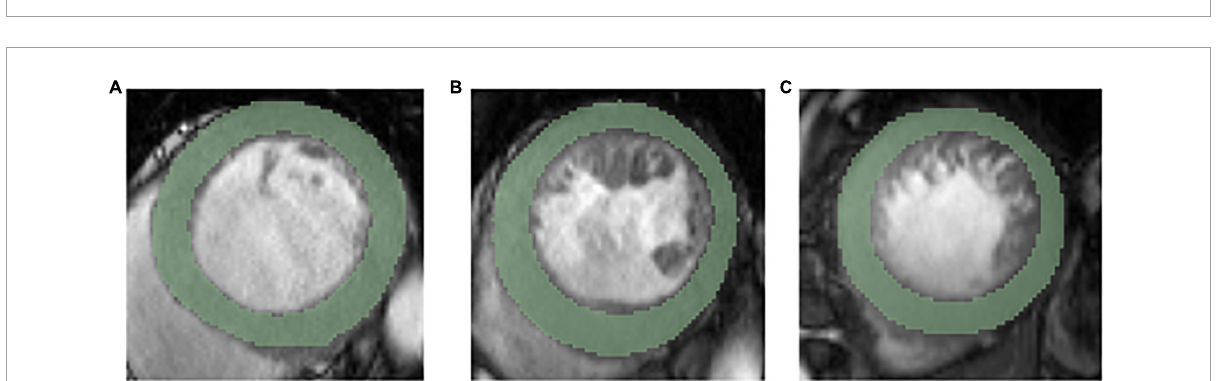
FIGURE1 The patient selection workflow.